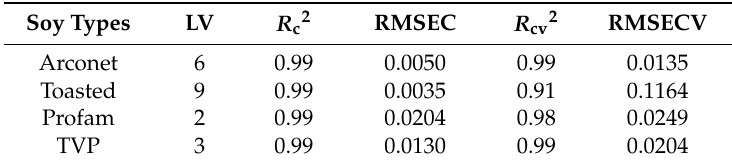
Table 1. Results of PLS regression based on dispersive spectra, PLS: partial least squares; RMSEC and